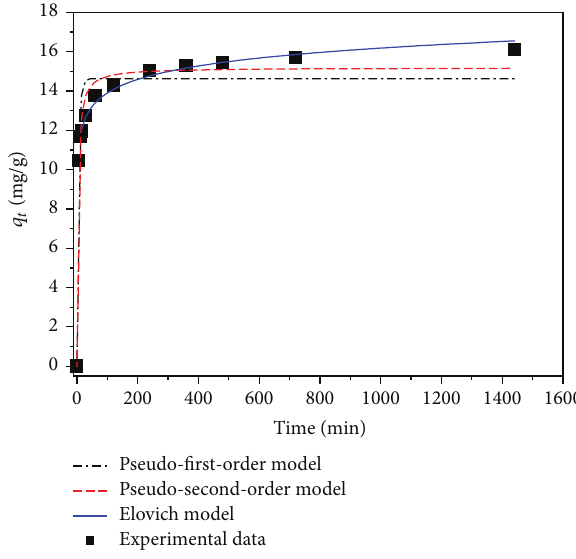
Figure 5: Nonlinear adsorption kinetics at pH 7.0 and fitted curves for ORII adsorption onto the CTAB-modified cornstalk